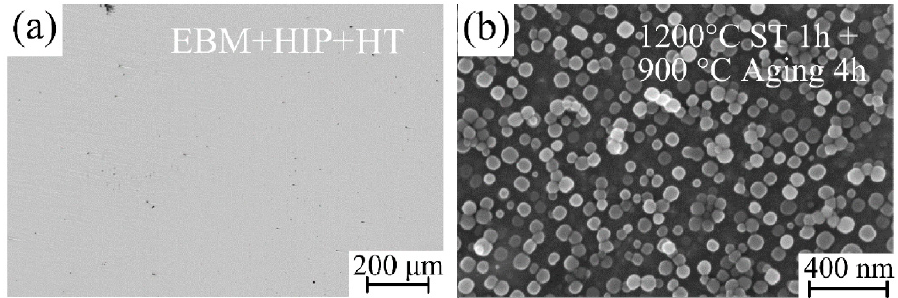
Figure 9. ( a ) The cracking incident after HIP+HT and ( b ) microstructural evolution in terms of γ′ precipitates. The internal structure appears to be crack-free in EBM+HIP+HT condition.